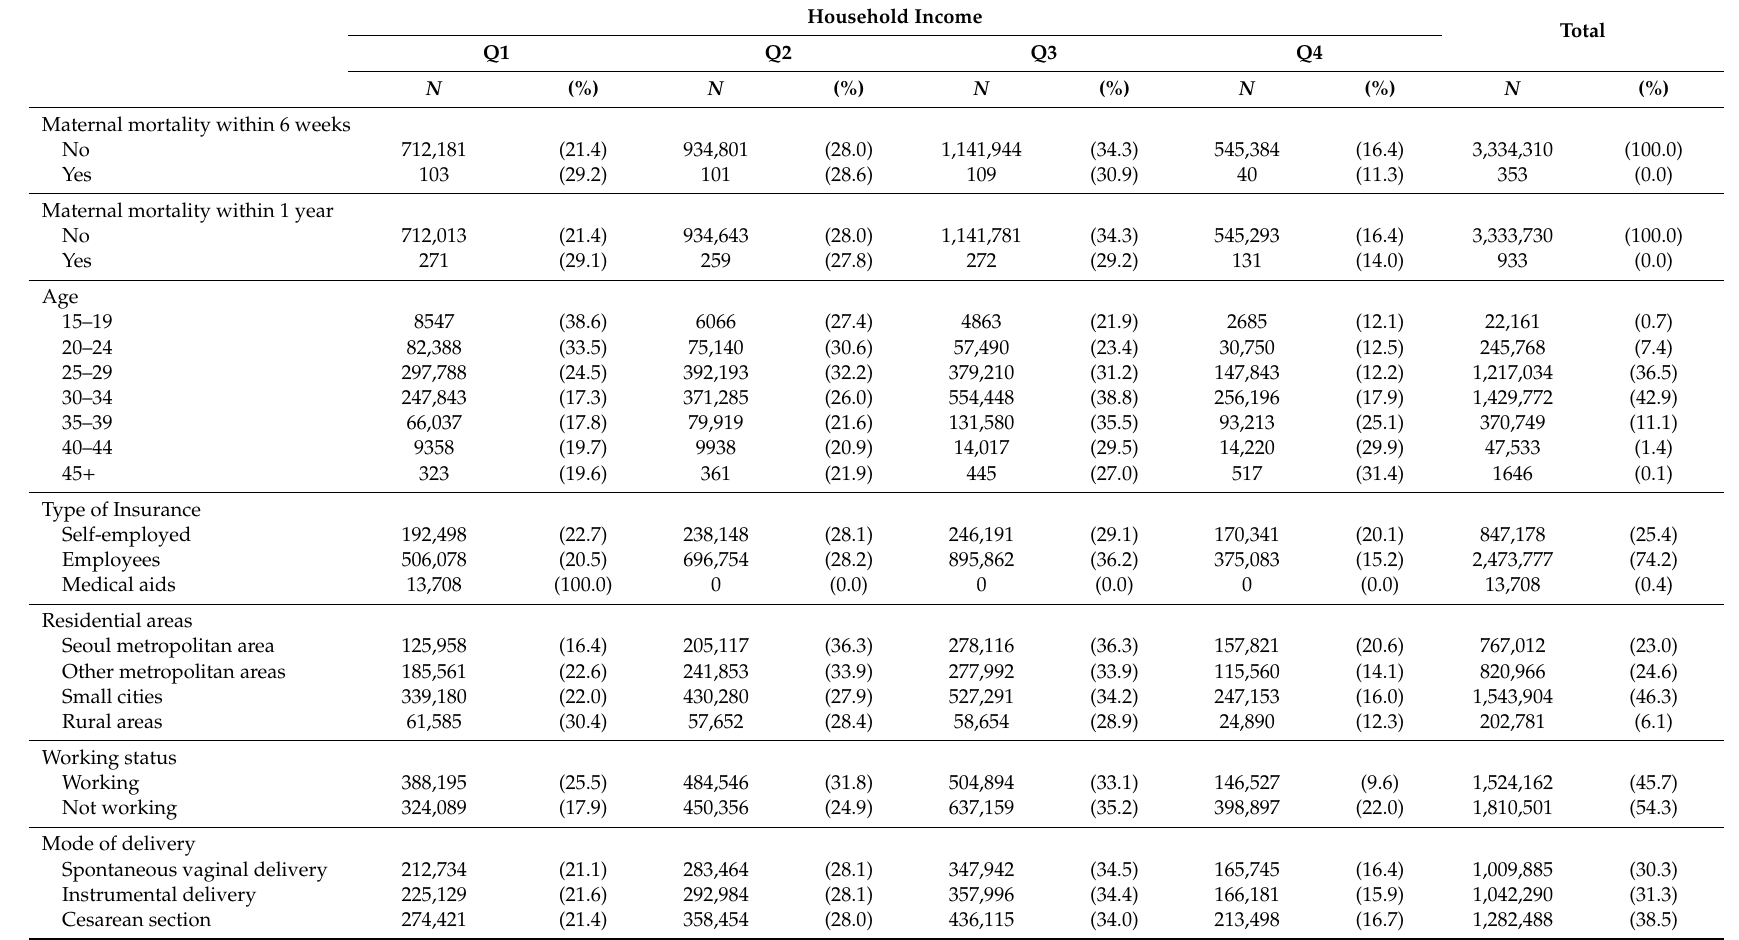
Table 1. General characteristic of study